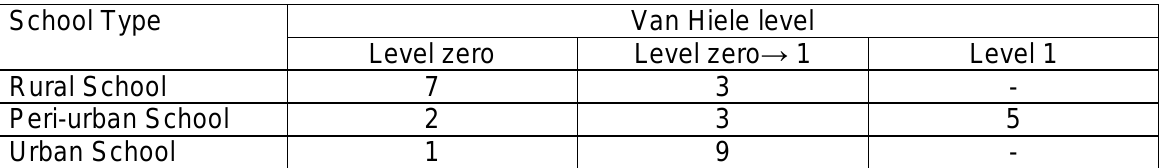
Distribution of number of learners at different Van Hiele levels per school type